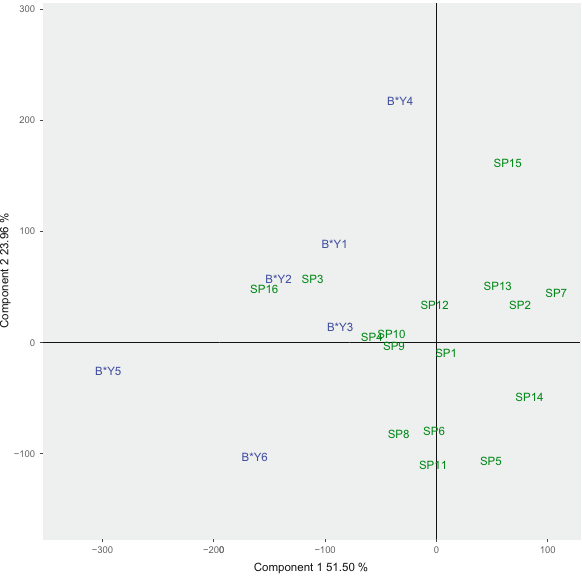
Figure 10: GYT biplot “ mean vs stability ” to rank the genotypes tested based on their superiority across all